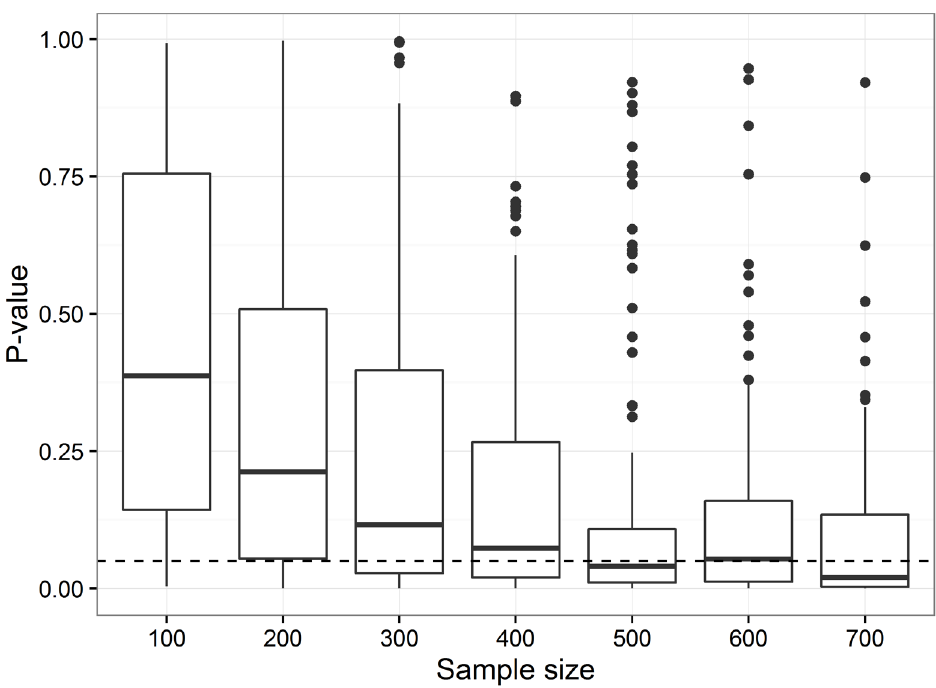
Figure 1. P-values increase as sample sizes decrease for the observed differences in low-density lipoprotein cholesterol (based on 500 simulations per sample size). The dotted horizontal line is the standard 5% threshold. The boxes are the 25th and 75th percentiles with the median as the central line. The upper whisker extends from the third quartile to the largest value no further than 1.5 * IQR from the quartile (where IQR is the inter-quartile range). The lower whisker extends from the 1st quartile to the smallest value at most 1.5 * IQR of the quartile. Data beyond the end of the whiskers are called ‘outlying’ points and are plotted individually.